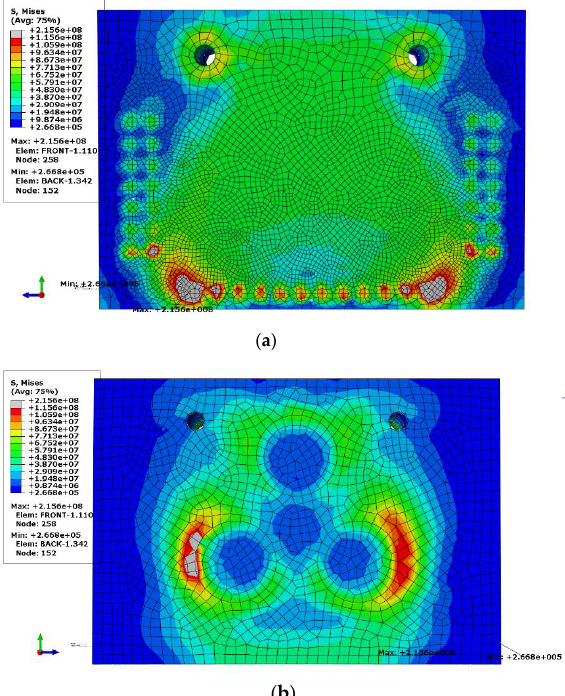
Figure 16. Stress components and invariants for ( a ) reaction (front) side and ( b ) forcing (rear) side.